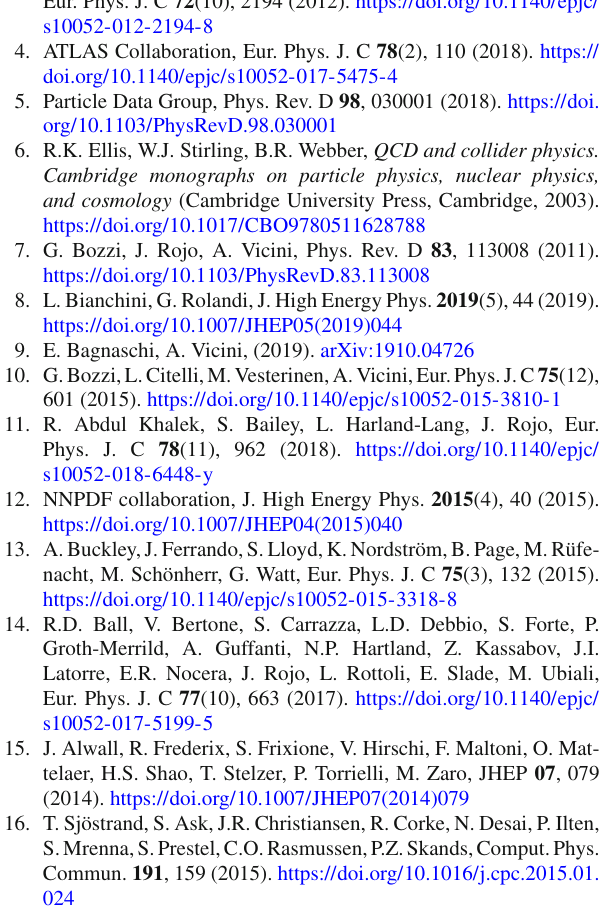
The shaded boxes correspond to the PDF systematic uncertainty, as described in the text. On the right side of each plot, the equivalent scale for the H W parameter is